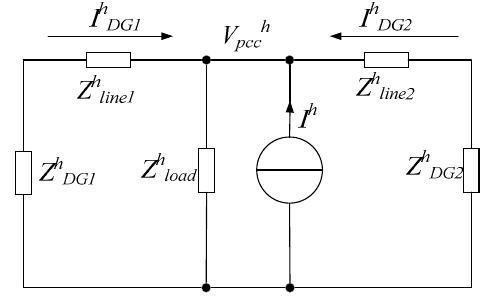
Figure 3. System equivalent circuit containing different frequencies.